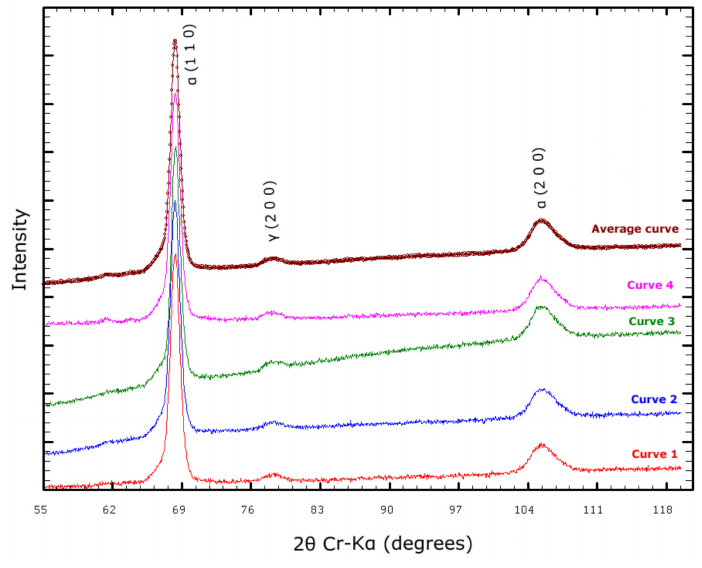
Figure 10. XRD patterns of sample AISI H13 in the AC condition.